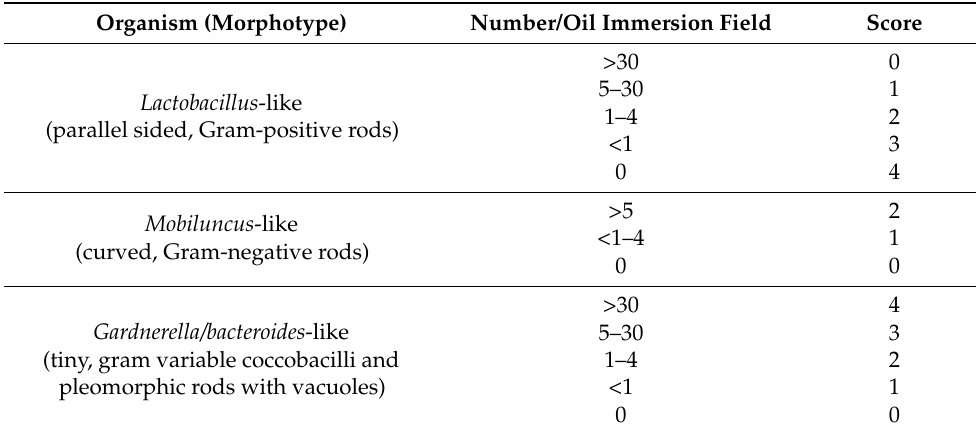
Table 1. The Nugent scoring of Gram-stained smears for diagnosis of bacterial vaginosis. Organism